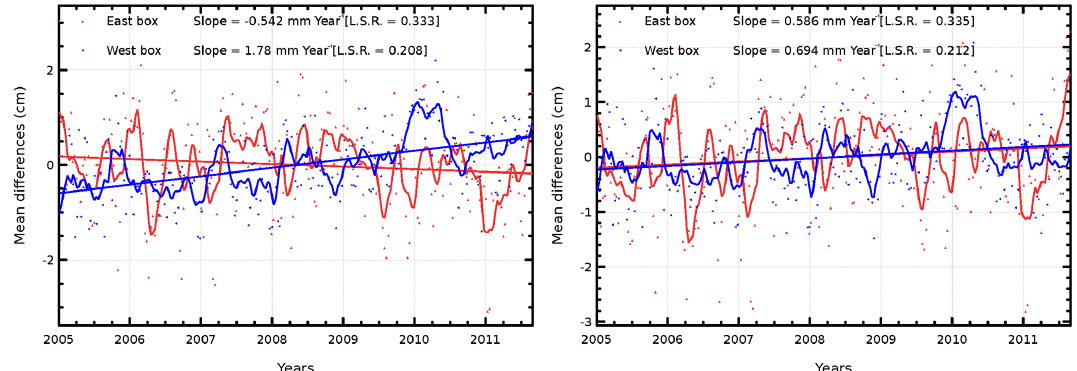
Figure 1. SSH differences (cm) between Jason-1 altimeter data (cycles 1 to 355) and Argo in situ measurements (900dbar) computed with GDR-D (a) and GDR-E orbit solution (b) , separating east box (Long: 60 ◦ /120 ◦ , Lat: − 30 ◦ / + 30 ◦ , in red) and west box (Long: − 150 ◦ / − 190 ◦ , Lat: − 50 ◦ /10 ◦ , in blue). Corresponding annual and semi-annual signals are removed. Trends of raw data (dots) are indicated and the 2-month filtered signal is added (curves).